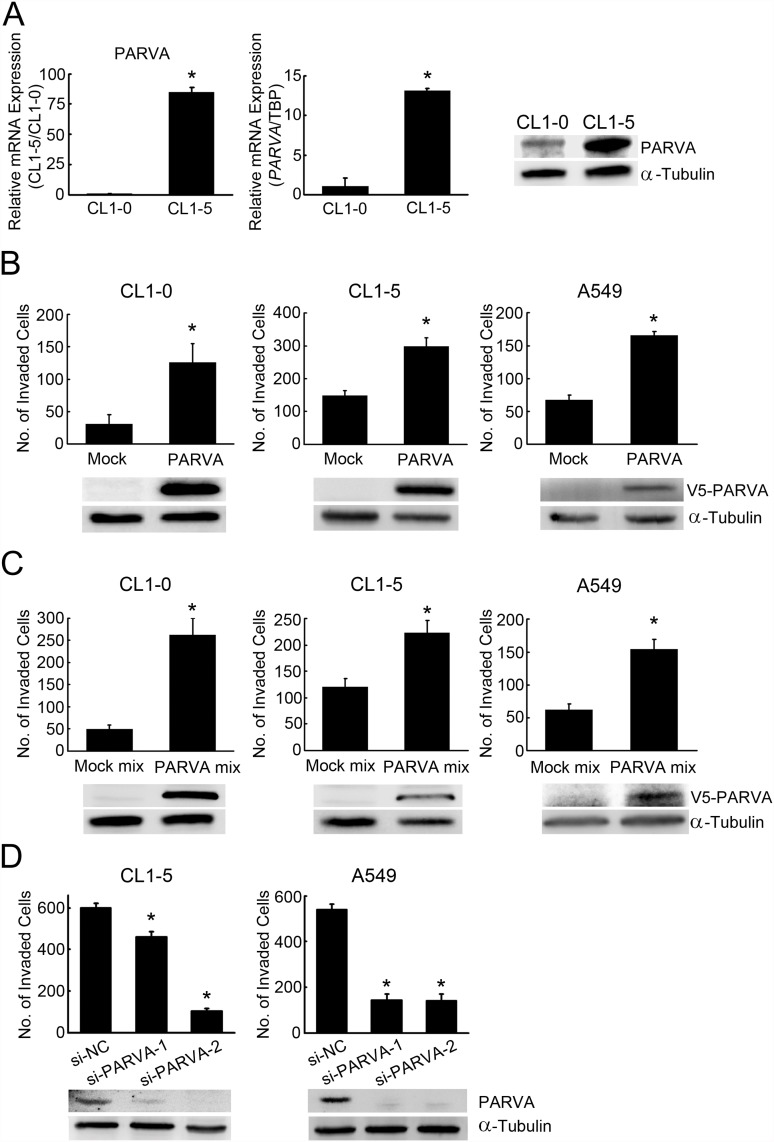
PARVA increases invasiveness in lung cancer cells.(A) PARVA is upregulated in highly invasive CL1–5 lung cancer cells compared with the less invasive CL1–0 cells. PARVA RNA and protein expression levels as determined by expression microarrays (left panel), real-time RT-PCR (middle panel) and Western blotting (right panel). (B) The effects of transient PARVA overexpression on cell invasion. CL1–0, CL1–5 and A549 cells were transiently transfected with the pcDNA3.1/V5-His TOPO-tagged PARVA construct or an empty vector, and the invading cells were evaluated by Boyden chamber assays. (C) The in vitro invasion ability of pooled, stably PARVA-overexpressing cells. CL1–0, CL1–5 and A549 cells were stably transfected with the pcDNA3.1/V5-His TOPO-tagged PARVA construct (PARVA mix) or an empty vector (Mock mix), and their invasive abilities were determined by Boyden chamber assays. (D) The in vitro invasion assay of PARVA-knockdown cells. Endogenous levels of PARVA were transiently silenced by two siRNAs, si-PARVA-1 and si-PARVA-2, in CL1–5 and A549 cells, and were detected using anti-PARVA antibodies. The invasive ability of the cells was analysed by Boyden chamber assays at 48 h after transfection. *, P < 0.05, compared with the mock control cells. The invasion data represent the average of three individual well counts ± SD. α-Tubulin was used as the loading control.